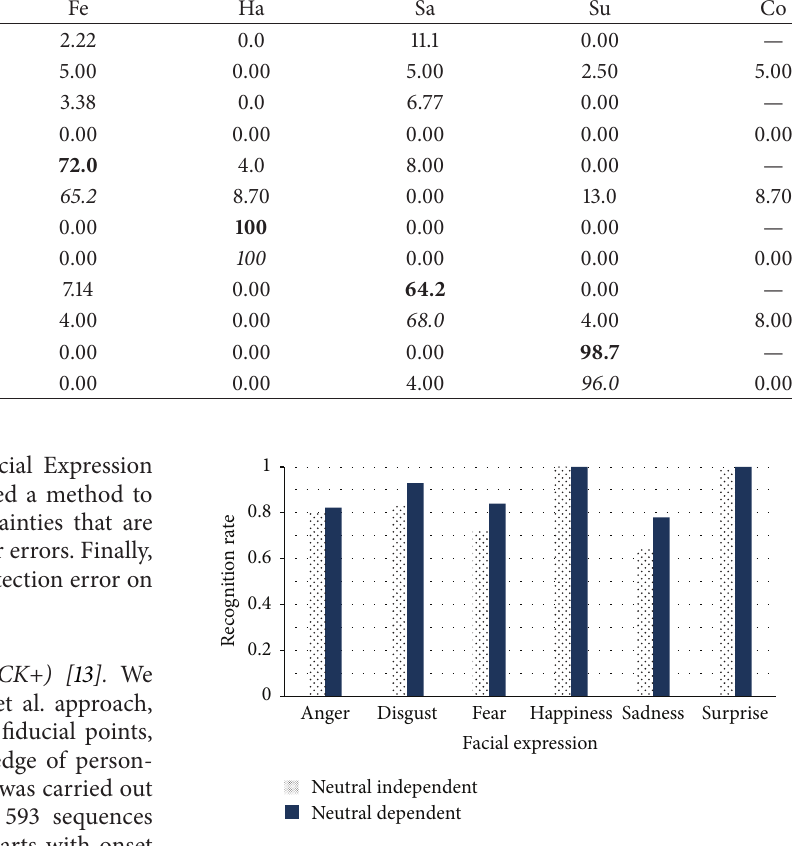
expressions: 45 for anger (An); 18 for contempt (Co); 59 for disgust (Di); 25 for fear (Fe); 69 for happiness (Ha); 28 for